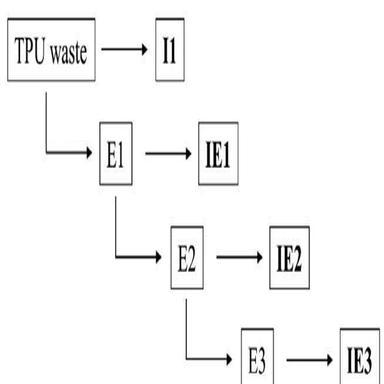
3D printing infill patterns.